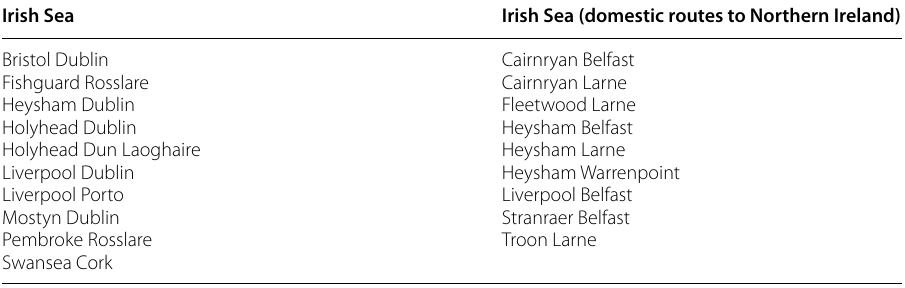
Table 2 Route 3 by Port Group—Irish Sea (including domestic routes to Northern Ireland) Irish Sea (domestic routes to Northern